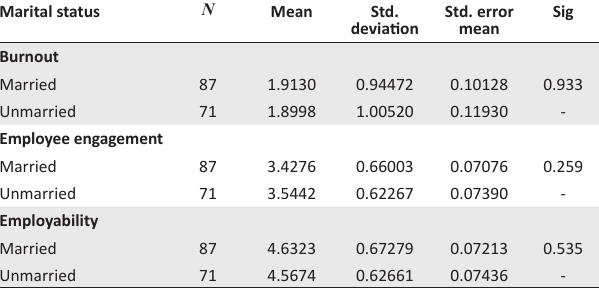
TABLE 8: Significant mean differences: Marital